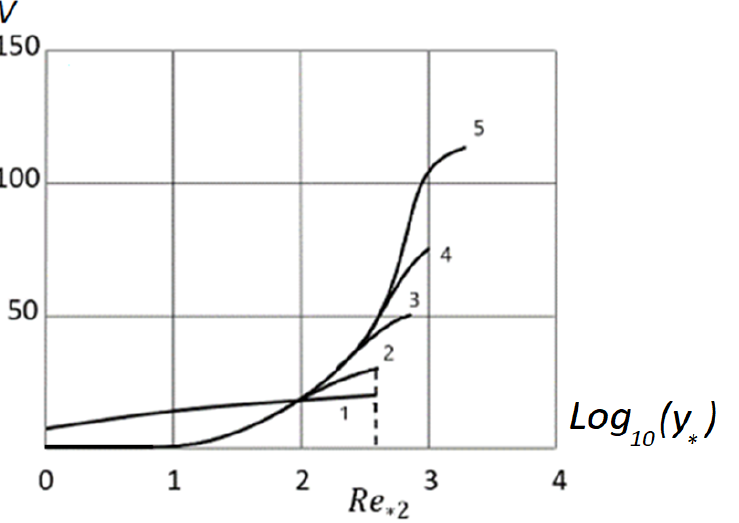
Figure 6. Velocity profiles: 1—turbulent one when Re ∗ = 413.2; 2—“laminar-type” one when Re ∗ = 413.2; 3, 4, 5—“laminar-type” ones when Re ∗ = 650, 1000, and 1625,